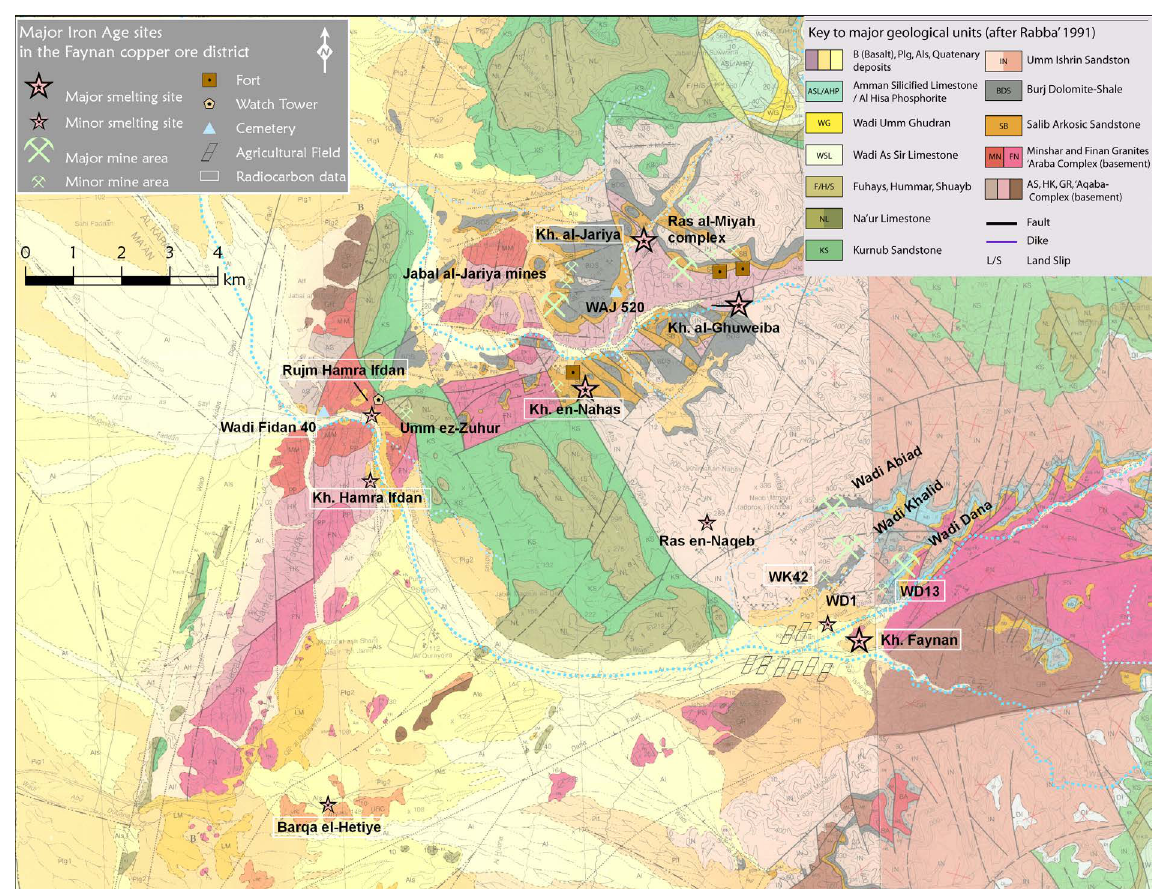
Figure 2. Simplified geological map of the Faynan region, Jordan with major Iron Age sites indicated. (Base map source: Rab'ba